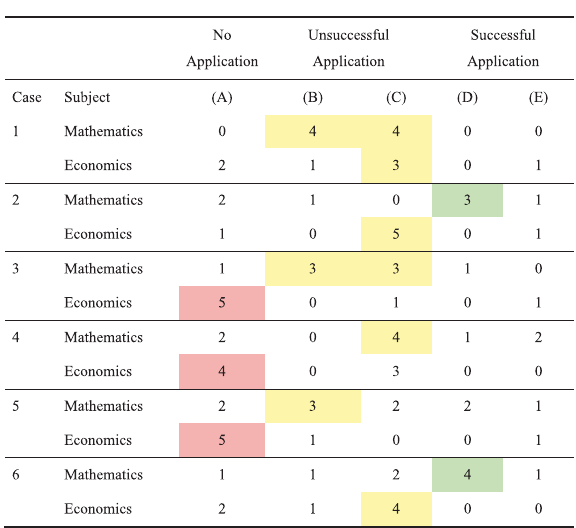
TABLE 2 | Number of categories coded for each case per subject. Most frequent categories per case and subject are highlighted.